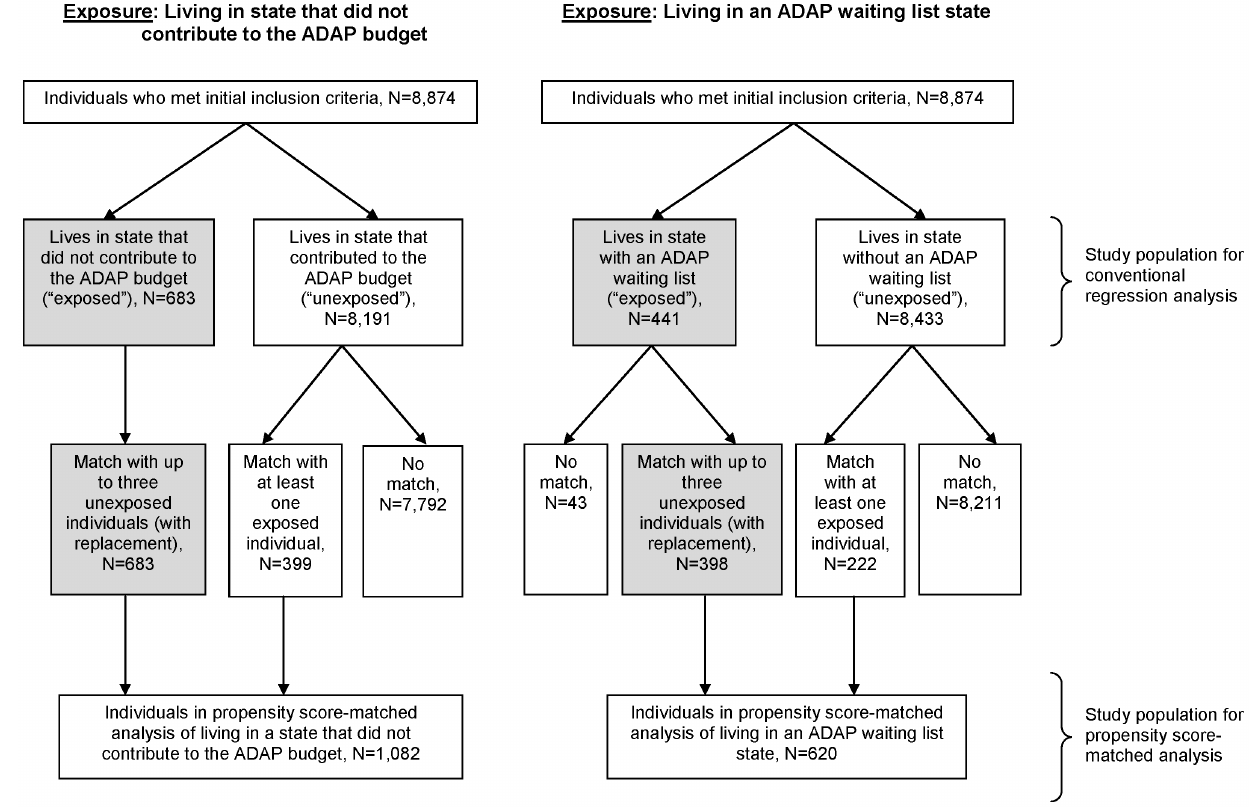
Figure 1. Flow charts showing selection into each of the two analyses. Gray indicates the population of interest for the propensity score- matched analyses.